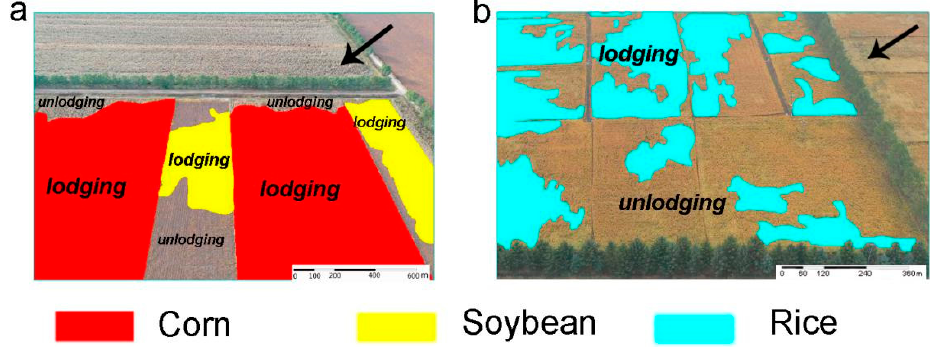
Figure 8. Lodging of ( a ) rice and soybean, and ( b ) maize. Red indicates corn lodging. Yellow indicates soybean lodging. Blue indicates rice lodging. Scale: a = 1:200, b = 1:120. Arrowa indicate the wind direction.